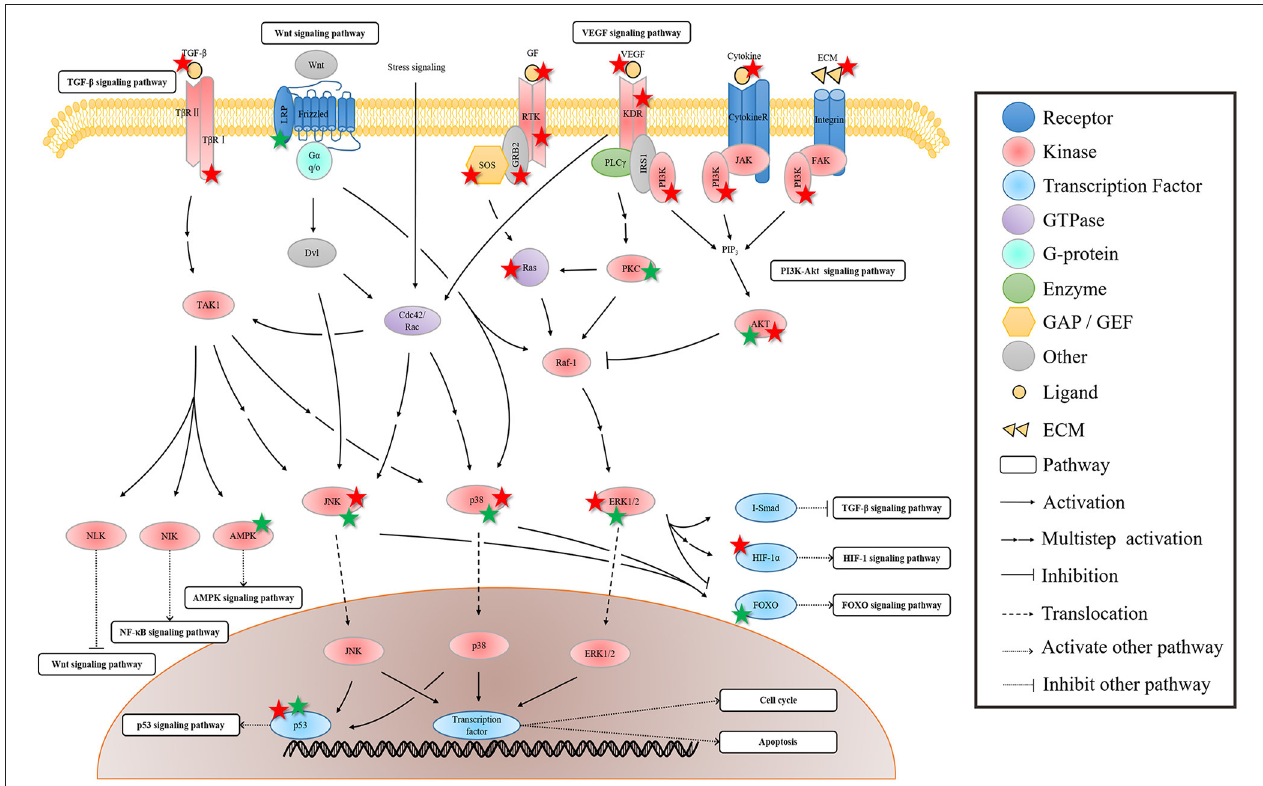
FIGURE 3 | The regulation of rhein on the crosstalk of MAPK signaling pathway. The MAPK signaling pathway is activated by the membrane receptors of several pathways, and then its downstream pathways are regulated. Rhein acts on multiple sites of these pathways to exert the extensive and effective pharmacological activity. The protein marked with star is the target of rhein. Red and green star represent negative and positive regulation,